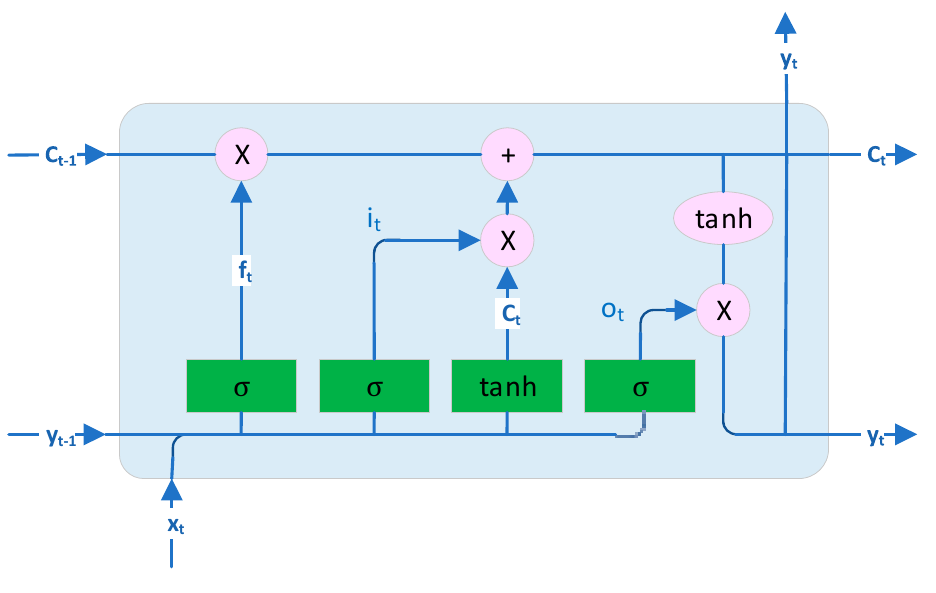
Figure 2. Standard LSTM cell.